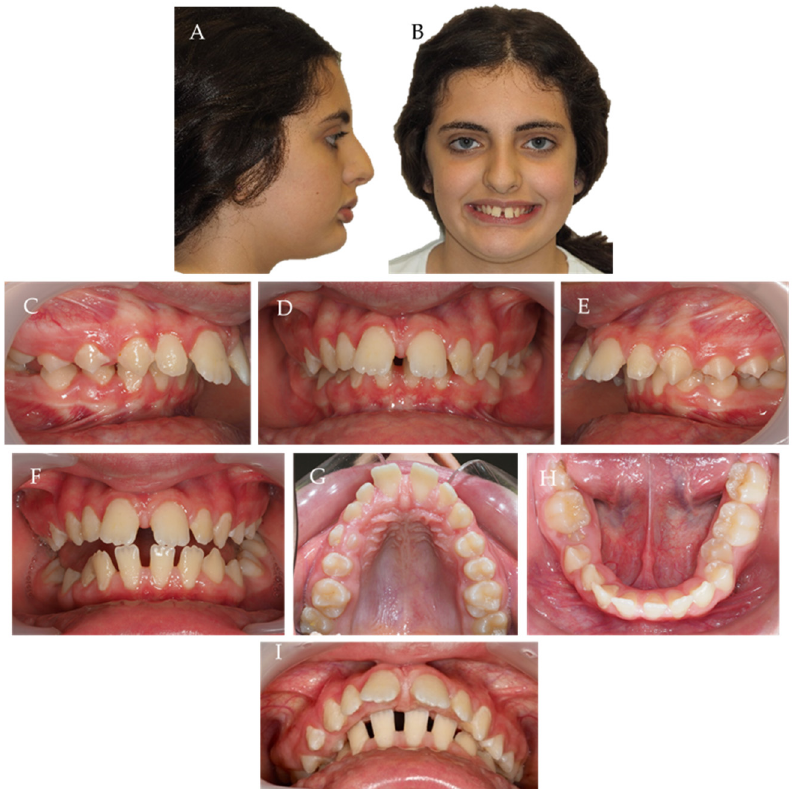
Figure 1. Twelve-year-old female child with a bilateral SB on the right side between teeth 14 to 43 and 17 to 47, and on the left side between teeth 25 to 35, with a severe overjet and overbite. ( A ) profile photo; ( B ) smile; ( C – E ) intra-oral photos in maximum intercuspation/centric relation; ( F ) protrusive guide; ( G , H ) occlusal photos; ( I ) overjet